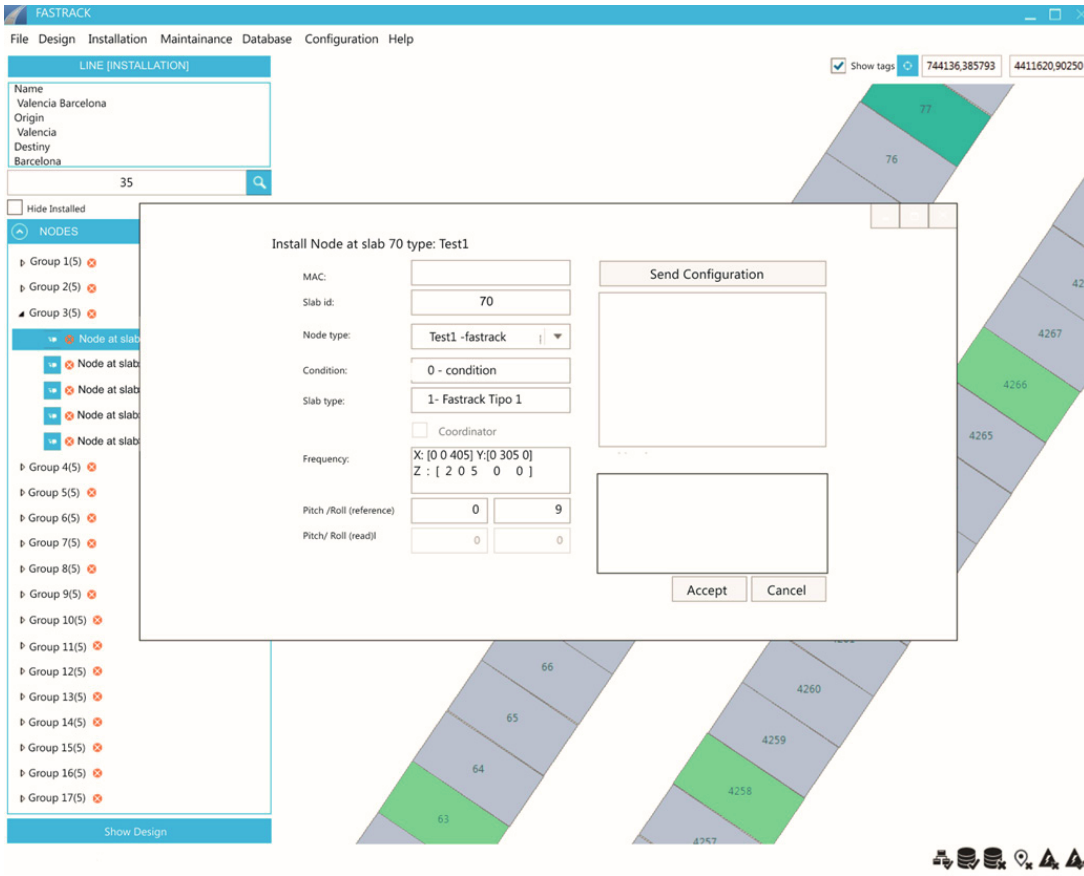
Figure 5. Control center: monitoring of tracks.